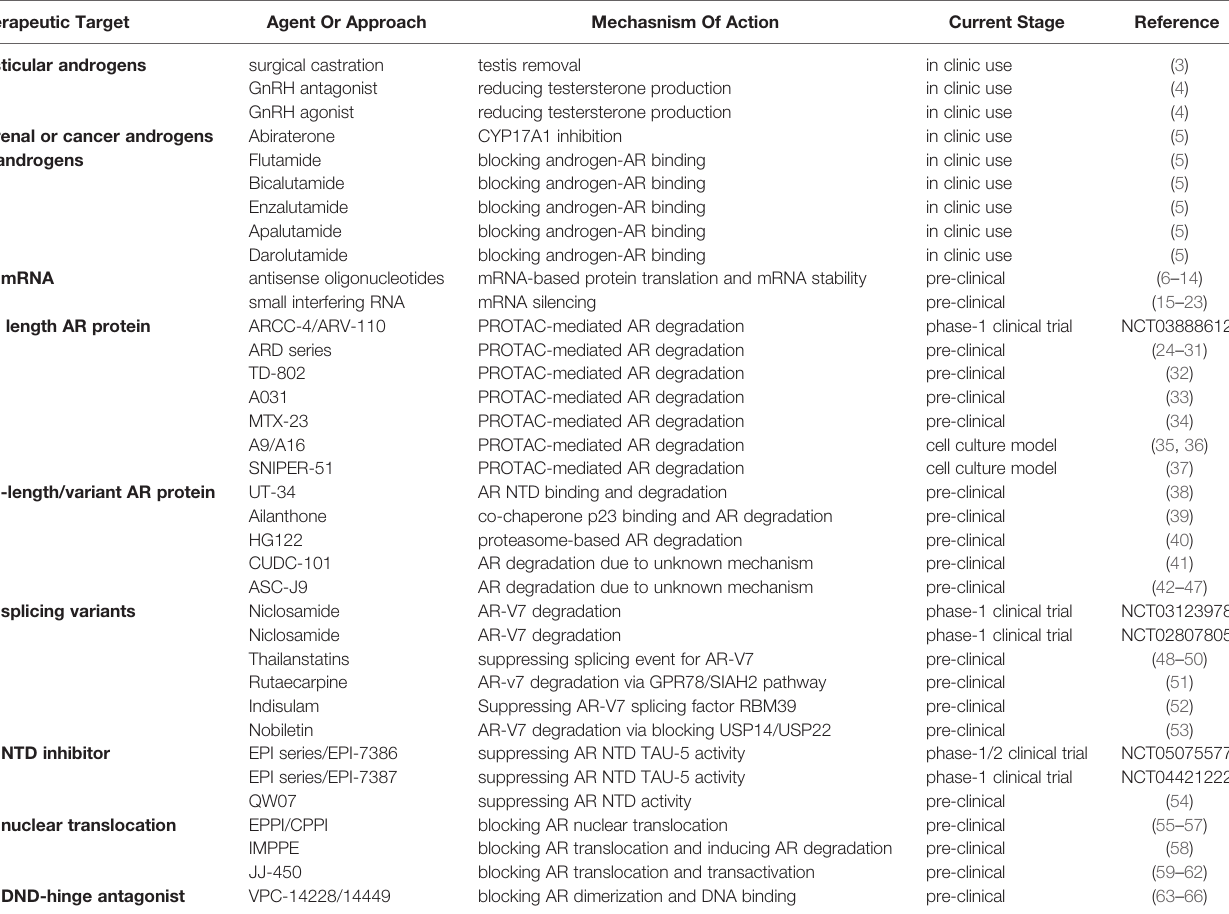
TABLE 1 | Summary of AR-targeted therapeutic agents for prostate